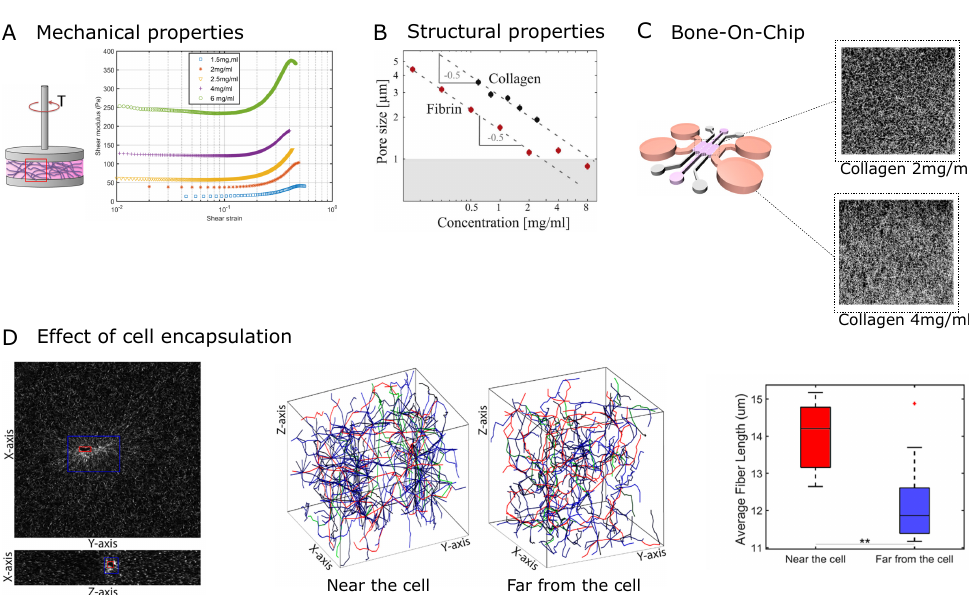
Figure 2. Hydrogels for bone-on-a-chip applications. ( A ) Hydrogel mechanical properties as a func- tion of network concentration. Scheme of a collagen hydrogel in the rheometer (left). Stress sweeps of five collagen hydrogels with different collagen concentration (right) after 24 h of polymerization (image from [64]). ( B ) Hydrogel structural properties as a function of network concentration. Concen- tration dependence of the average pore size of fibrin (red) and collagen (black) gels (image from [65]). ( C ) Reconstituted collagen-based hydrogels within a microfluidic chip. Maximum intensity projection in the Z direction of a 2 mg/mL and a 4 mg/mL 3D collagen type I network structure. Fiber images obtained with Nikon D-Eclipse C1 equipped with a 40X oil objective (image from [66]). ( D ) Effect of cell encapsulation within a collagen hydrogel. 3D reconstruction of collagen fibers in the vicinities of the cell or far from the cell (middle figures). Changes on average fiber length for the regions near the cell and far from the cell (right) (image from [66]). Images taken with permission from